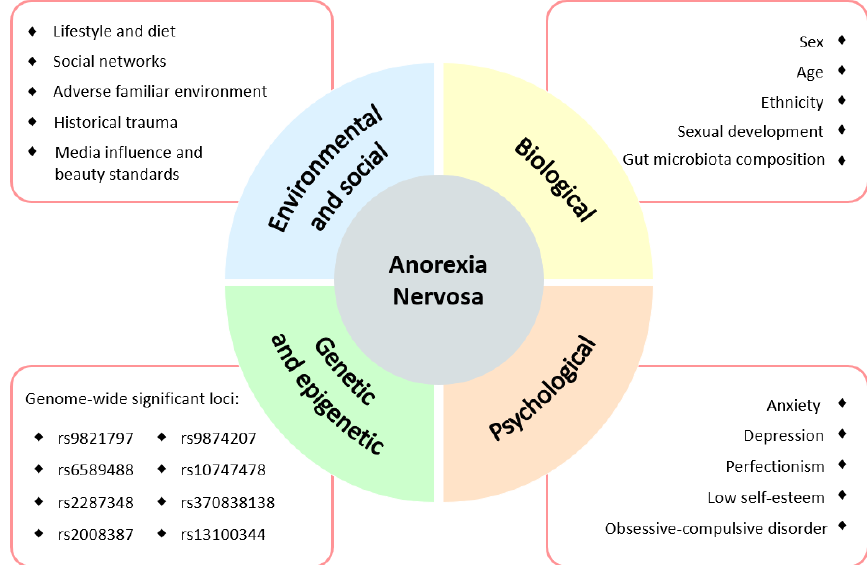
Figure 1. Main factors predisposing to the development of anorexia nervosa [21,22]. Once the disease starts, the maintained weight loss and the altered eating behaviors of the patients lead to wide metabolic dysfunctions complicating the overall clinical picture of the disorder. Among the metabolic alterations, individuals with anorexia nervosa are commonly found to present mild plasma hyper aminoacidemia [23], increased cholesterol levels [24,25], electrolyte imbalances leading to hyponatremia and hypokalemia [26], and profound endocrine disturbances [27–29]. AN patients are reported to have lower triiodothyronine (T3) and thyroxine (T4), showing an altered hypothalamic- pituitary-thyroid axis [26]. In addition, increased cortisol levels in serum and urine have been found, suggesting hyperstimulation of the HPA axis [30,31]. Moreover, patients also have distorted appetite-regulating mechanisms, characterized by increased levels of peptide PYY and ghrelin and decreased concentrations of leptin [26,31–34]. Finally, their extreme eating behaviors lead to micronutrient deficiencies, including reduced levels of zinc, copper, vitamin C, riboflavin, and vitamin B6 [26,35]. Nutritional deprivation